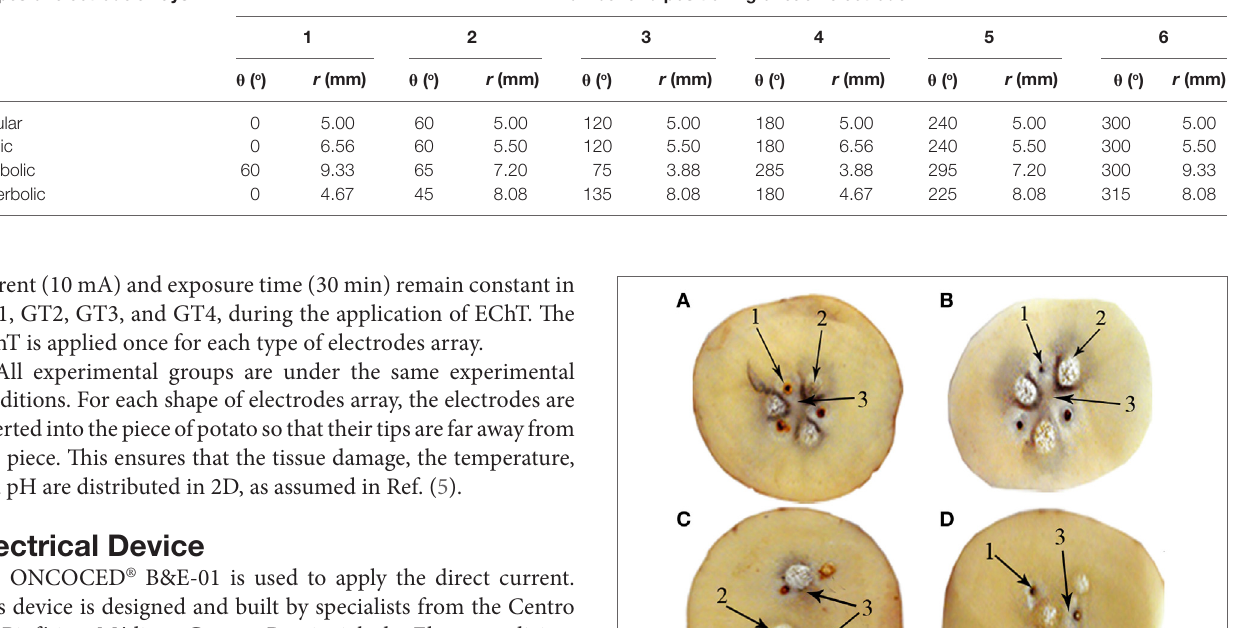
a universal method, and its results comply with those obtained with pH-meters in tumors (16). In the NCG, pH is measured randomly in different parts of the potato piece. In the PCG and the four treated groups, the pH is measured around and between the electrodes, as well as on areas away from